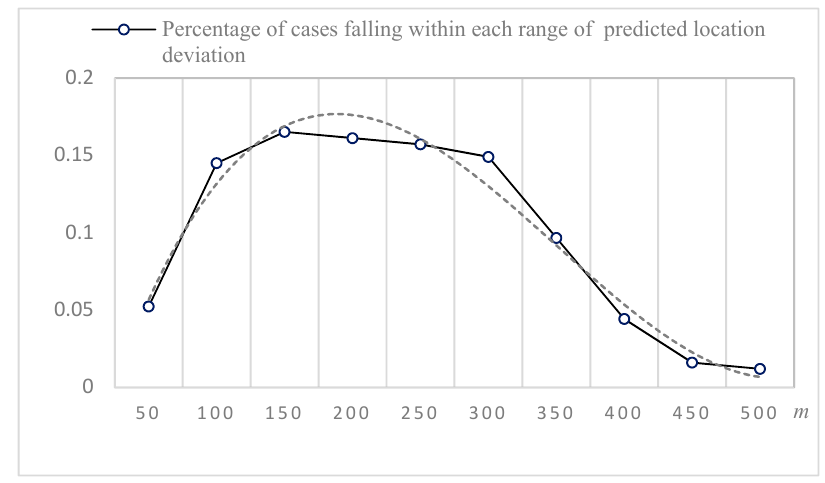
Figure 8. Statistics of the deviations between the predicted and observed locations within each 401